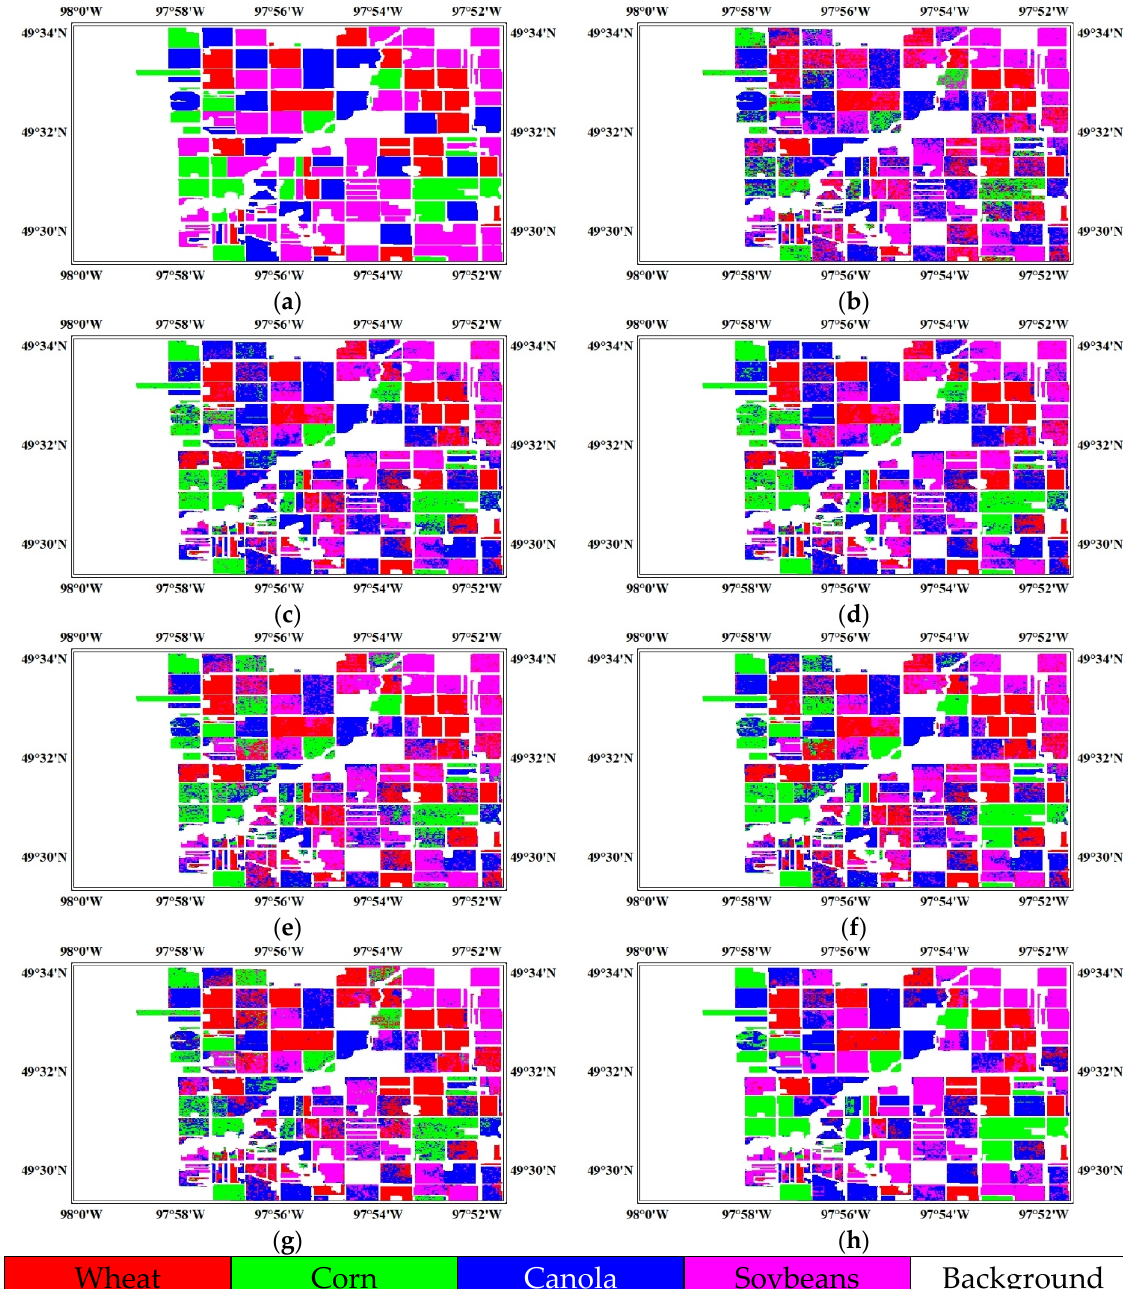
Figure 4. Ground truth map and classification maps in Winnipeg (SD: A -> TD: C), generated by different methods: ( a ) Ground truth; ( b ) DAC; ( c ) TCA+DAC; ( d ) SSTCA+DAC; ( e ) MIDA+DAC; ( f ) SMIDA+DAC; ( g ) SMbDA+DAC; ( h ) WSMbDA+DAC.